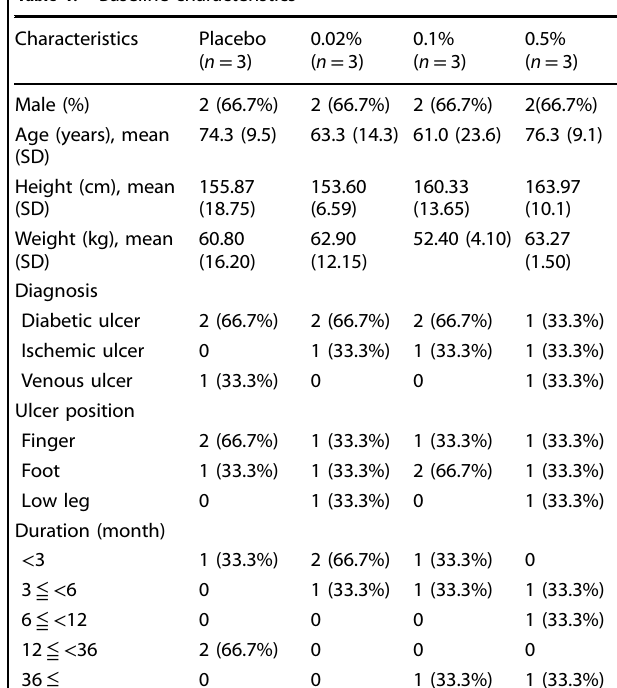
Table 1. Baseline